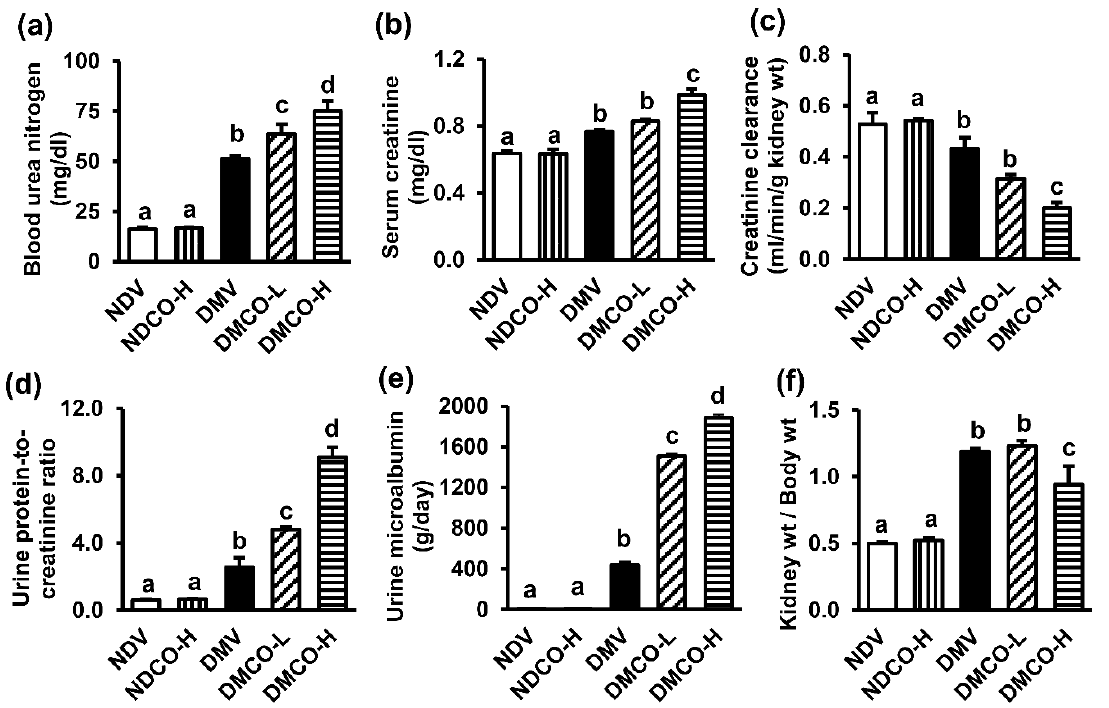
Figure 2. Effects of crocodile oil on renal functional parameters at the age of 40 weeks: ( a ) blood urea nitrogen; ( b ) serum creatinine; ( c ) creatinine clearance; ( d ) urine protein-to-creatinine ratio; ( e ) urine microalbumin; ( f ) kidney-to-bodyweight ratio. Values are mean ± SEM (n = 5 each). NDV: nondiabetic treated with vehicle; NDCO-H: nondiabetic treated with high-dose crocodile oil; DMV: diabetic treated with vehicle; DMCO-L: diabetic treated with low-dose crocodile oil; and DMCO-H: diabetic treated with high-dose crocodile oil. Different lowercase letters denote statistical differences at p < 0.05 between groups.